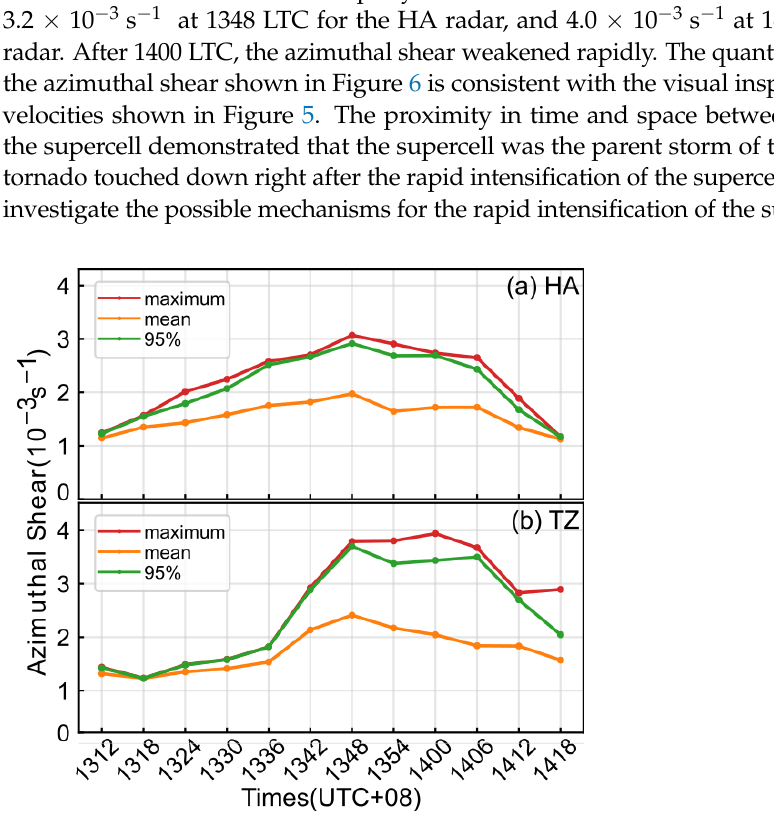
Figure 6. Evolution of the azimuthal shear of the HA ( a ) and TZ ( b ) radars at the 0.5° elevation angle from 1312 to 1418 LTC. The red, orange, and green lines are the maximum, mean, and 95% percentile of the azimuthal shear, respectively.